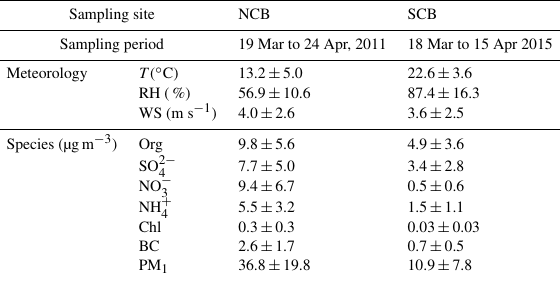
Table 1. Meteorological conditions and PM 1 species concentrations during NCB and SCB